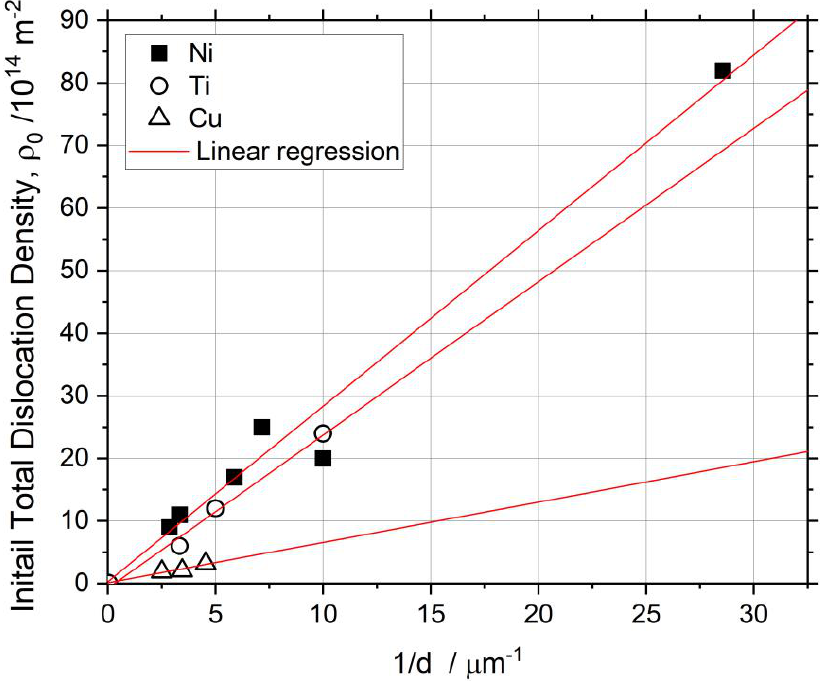
Figure 4. Initial dislocation density scaling with the inverse grain size in ultrafine-grained Ni [81], Ti [82] (cf. also similar data in [83]), and Cu [43].